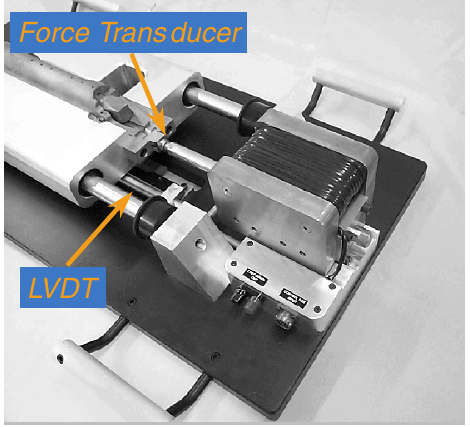
Fig. 5. Transducer placement for MR gun recoil